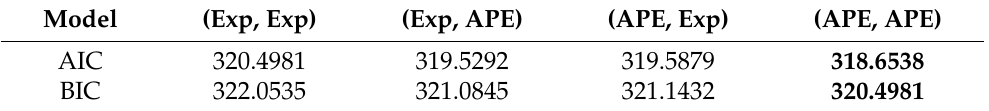
Table 16. AICs and BICs for model selection.